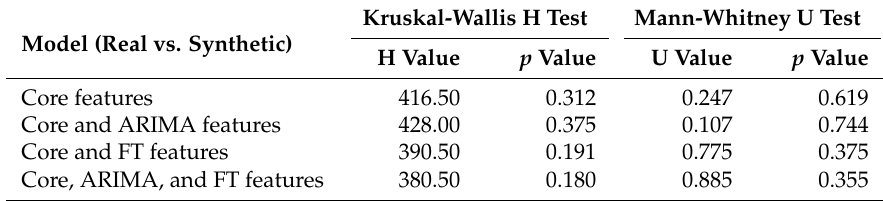
Table 2. Kruskal-Wallis H Test and Mann-Whitney U test (UCI data set).